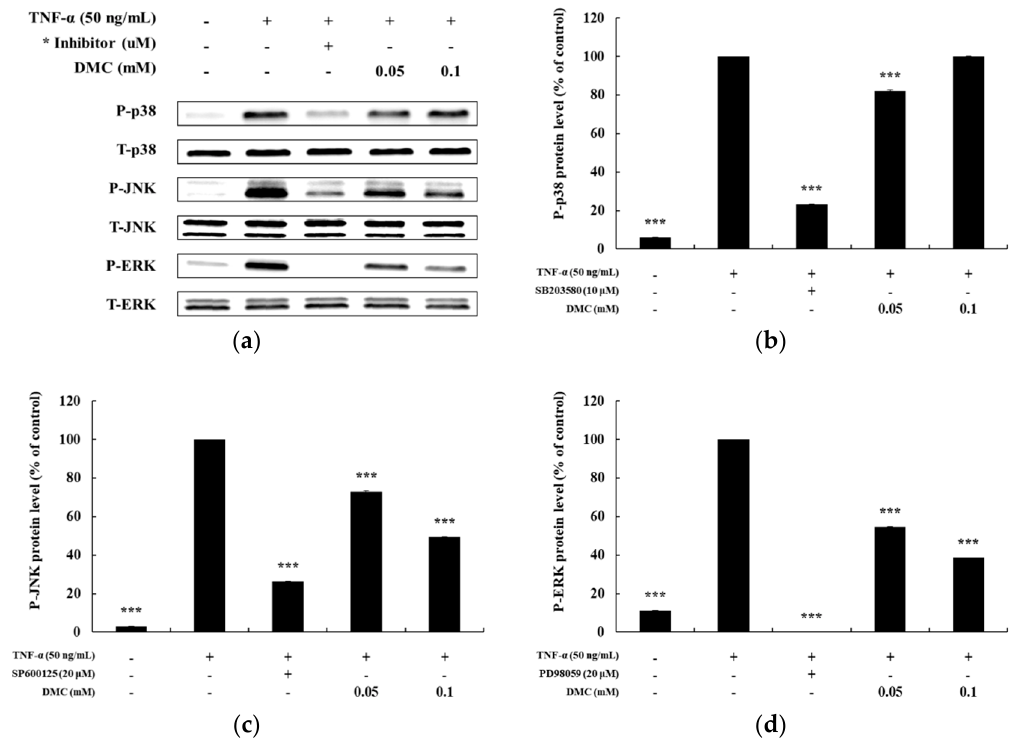
Figure 5. Effect of DMC on the expression of p38, c-Jun N-terminal kinases (JNK), and extracellular- signal-regulated kinase (ERK) in TNF- α -treated HaCaT cells. ( a ) cells were pretreated with various concentrations of DMC (0.05 and 0.1 mM) for 1 h and then stimulated with TNF- α for 10 min followed by western blotting of the cell lysates with the indicated antibodies. ( b ); ( c ); and ( d ) quantitation of the protein levels of P-p38 (b), P-JNK (c), and P-ERK (d), are presented as mean ± SD (n = 3). *** p < 0.001 vs. TNF- α - treated control.